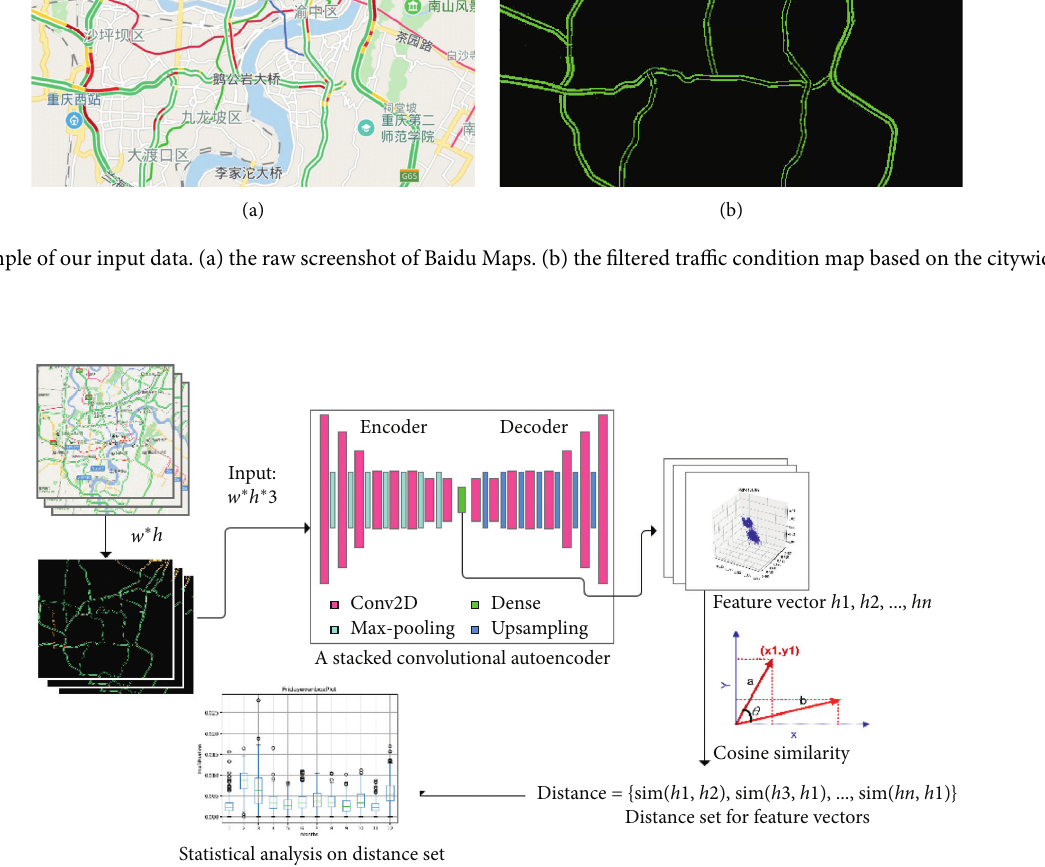
Figure 2: Our proposed method framework. The input is a series of NRTM with the size of w × h × 3. They are fed to a stacked convolutional autoencoder and transformed into a series of three-dimensional feature vectors. The distances between vectors are measured by cosine similarity. Then, the statistical analysis describes their distribution